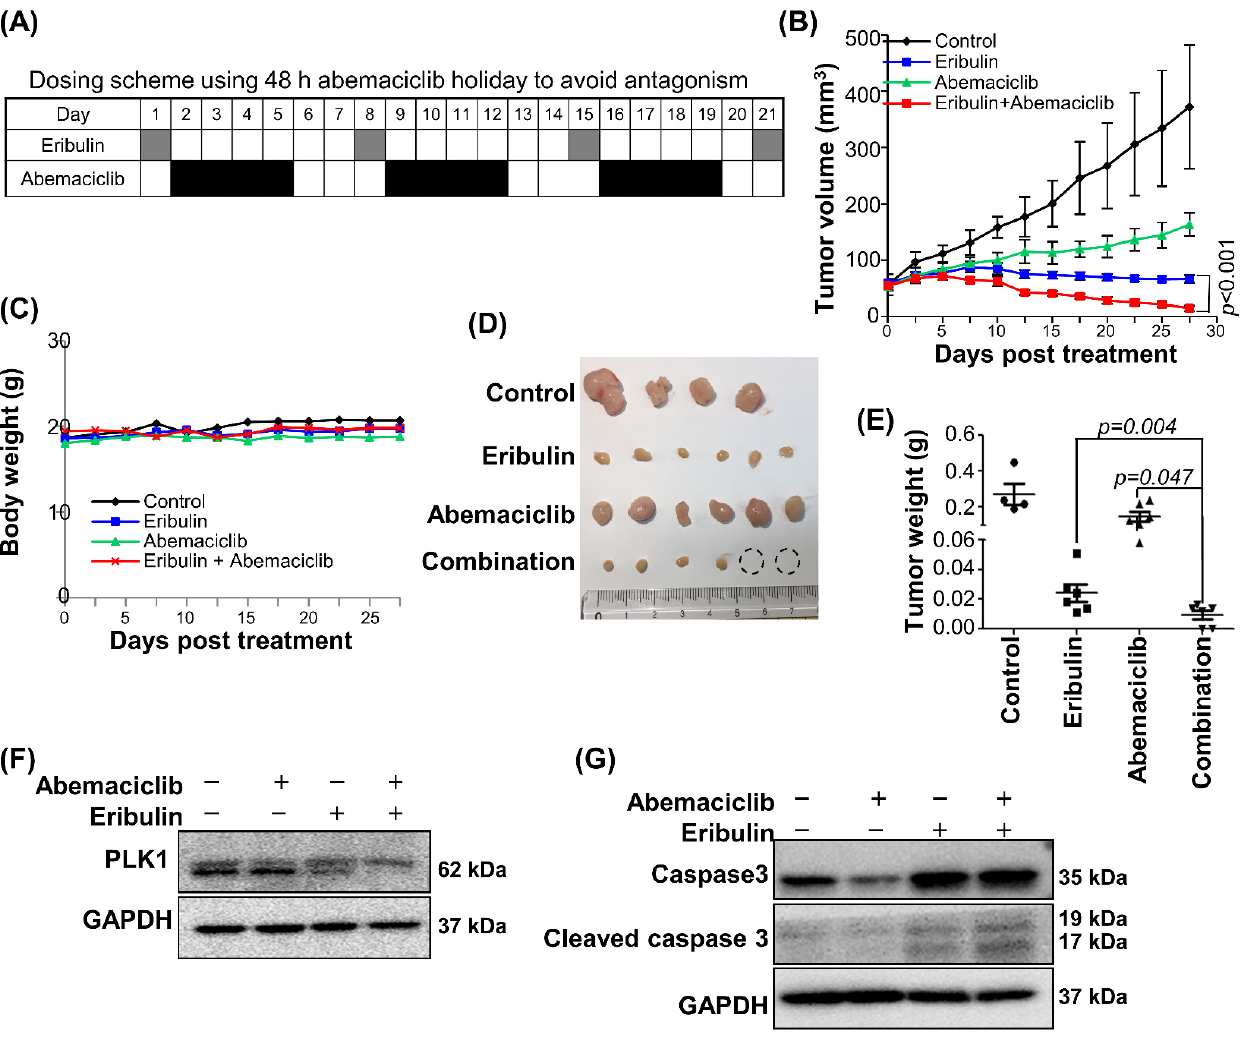
Figure 5. Combined eribulin and abemaciclib treatment enhances in vivo antitumor activity in palbociclib-resistant breast cancer xenograft. ( A ) Drug dosing scheme for the in vivo experimental procedure. ( B ) Mean tumor growth curve of MCF7-PR xenograft treated with eribulin, abemaciclib, or a combination of those two. Tumor volumes were monitored every 2-3 days. p -value was calculated with two-way analysis of variance after Bonferroni correction on day 28 after drug treatment initiation. Data are presented as the mean ± standard error of the mean (SEM). ( C ) The mice body weight graph indicated that drug treatment did not cause any bodyweight loss. ( D ) Xenografted tumors were harvested from each group of mice at the end of the experiment. Dotted circles indicated complete tumor regression. ( E ) The weights of the tumors were measured. p -values were calculated by Student’s t-test. Data are presented as the mean ± SEM. NS indicates not significant. All the student’s- t -test performed were two-tail and unpaired. ( F , G ) Western blot using MCF7-PR xenograft after 28 days of treatment showed a greater PLK1 suppression and cleaved caspase-3 induction in the combination group than eribulin or abemaciclib single-treatment groups. Full length blots (F and G) are presented in Figure S5